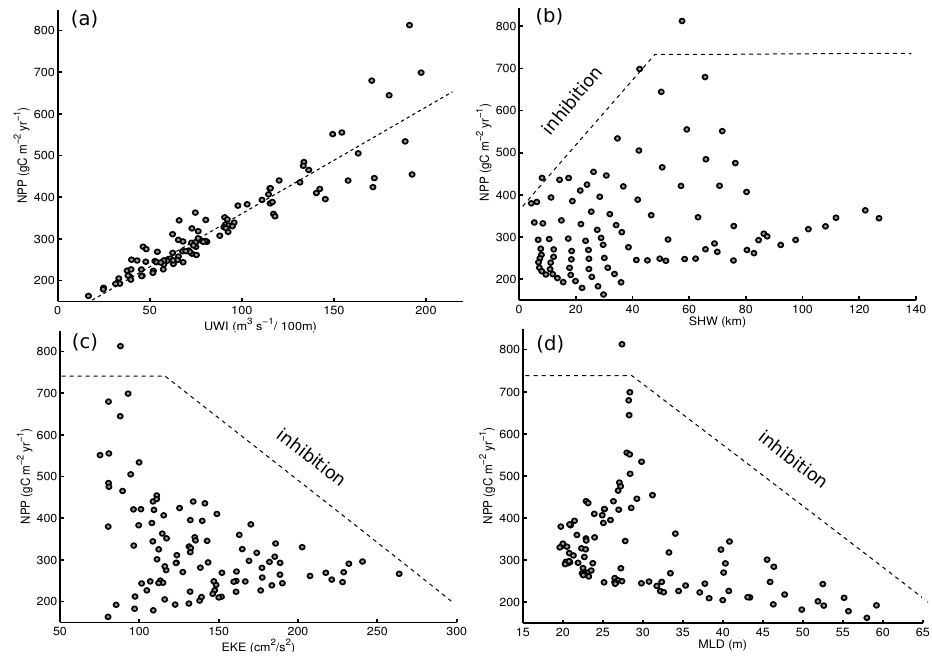
Fig. 6. The relationship of NPP to the drivers: (a) upwelling index, (b) shelf width, (c) eddy kinetic energy, and (d) mixed layer depth among SOM